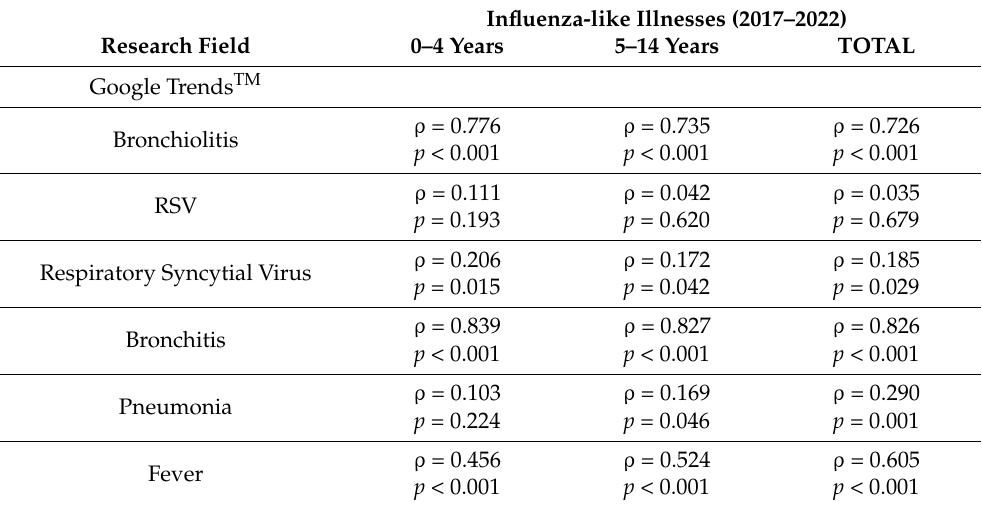
Table 7. Correlation between weekly notification rates for ILI and relative volume searches for a series of Google Trends TM keywords, and daily visualizations for selected Italian Wikipedia pages (2017 to